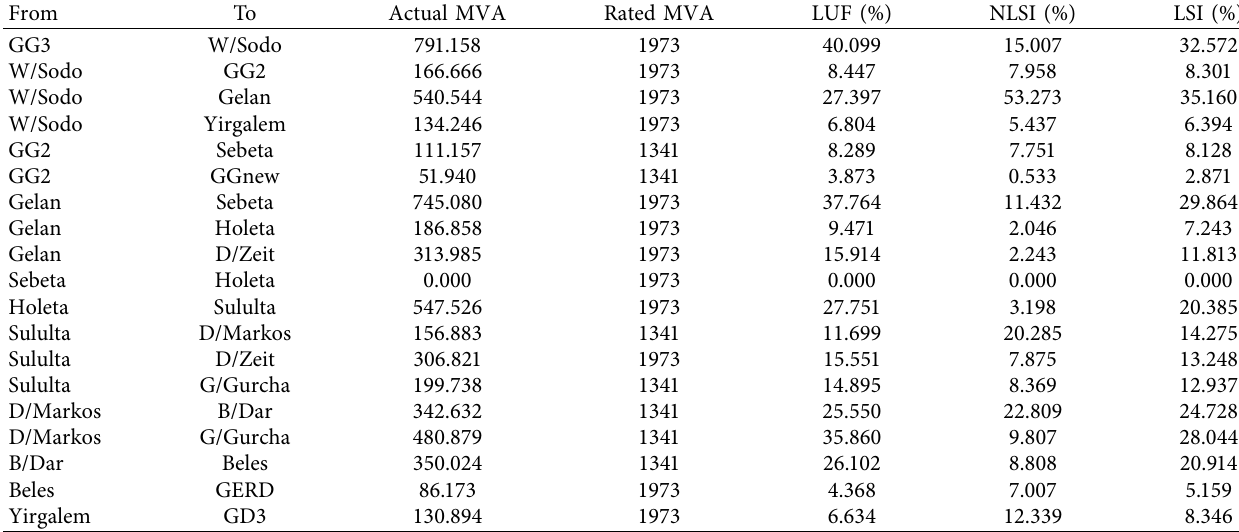
Table 10: LSI during an outage of Sebeta to the Holeta branch with IPFC.